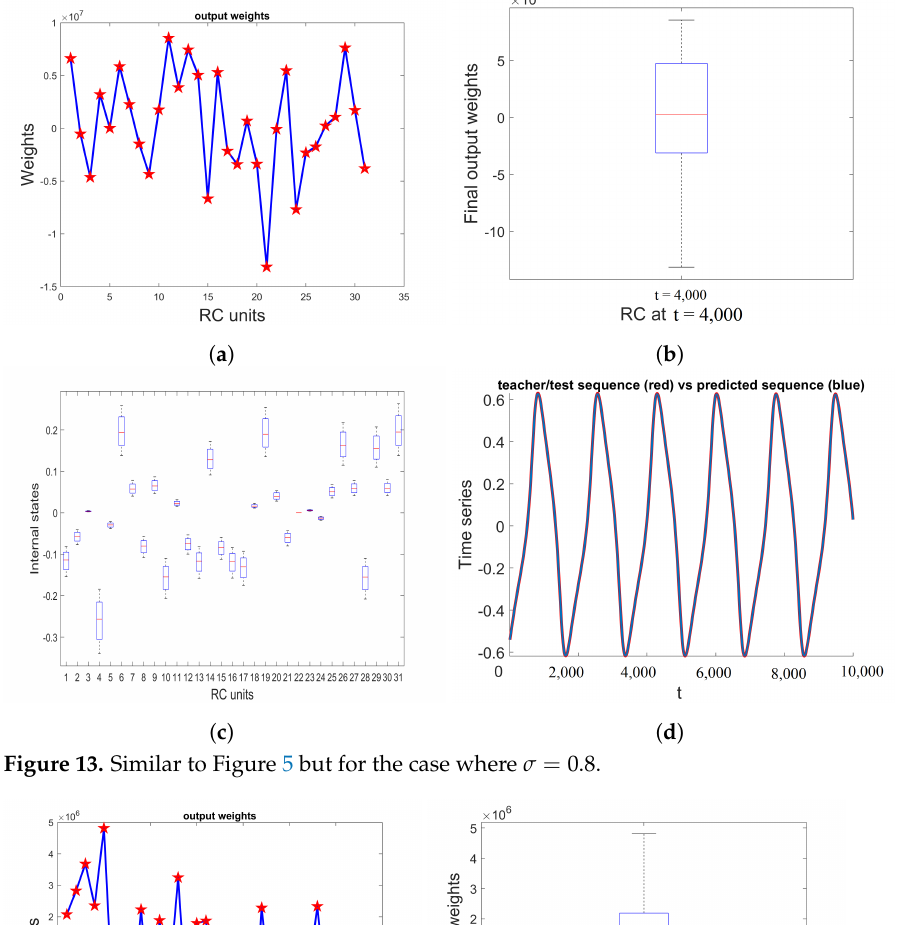
Figure 13. Similar to Figure 5 but for the case where σ = 0.8.